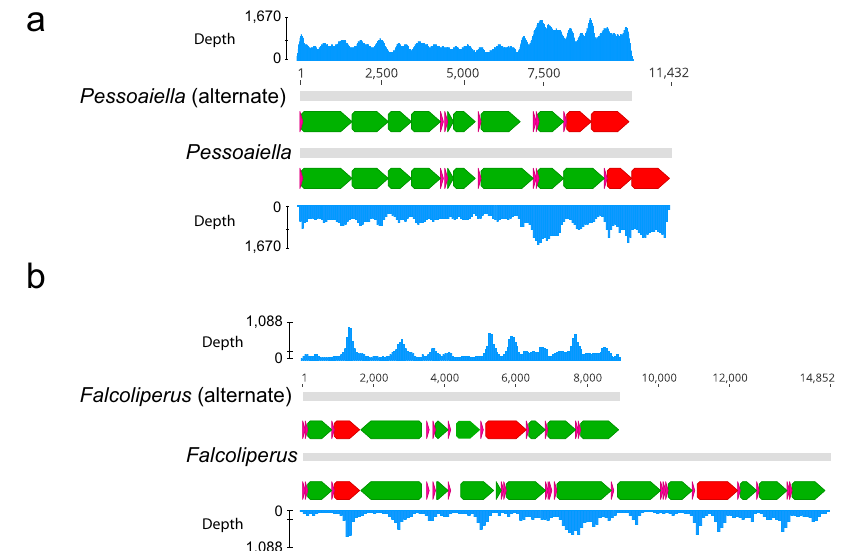
Fig. 2 Evidence for heteroplasmic chromosomes in two species of lice. Heteroplasmic gene arrangements in ( a ) Pessoaiella and ( b ) Falcoliperus . The fragments are arbitrarily linearized to compare gene orders. The fragments are also shown with sequence coverage at each position. Genes are indicated with arrows (Green = protein coding gene; Green = rRNA; Pink = tRNA). Lengths (in base pairs) are indicated above each pair of fragments.